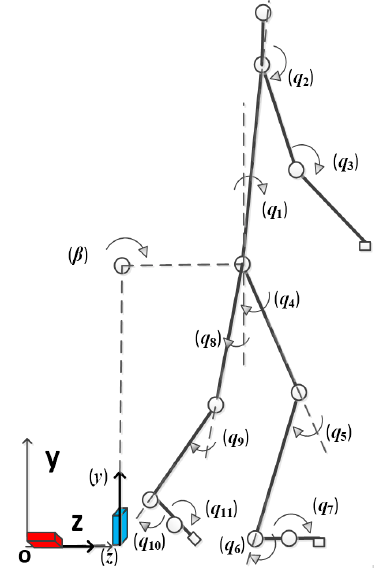
Figure 1. The 2D skeletal model.